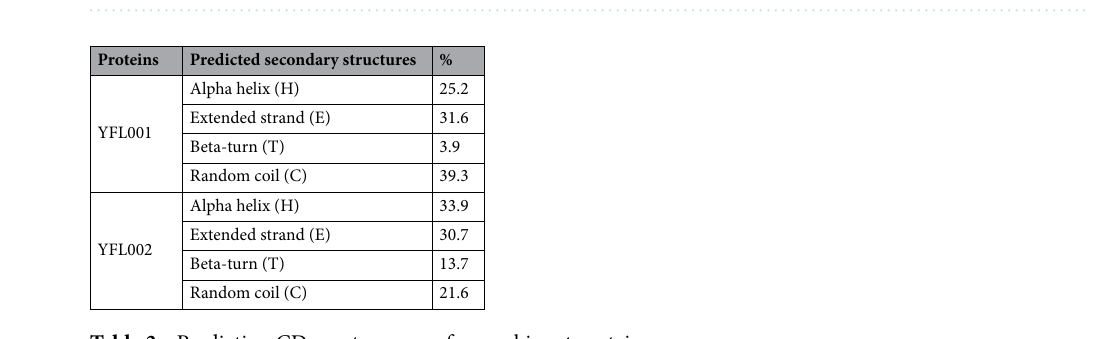
Figure 7. CD structural analysis of the recombinant proteins: (A) Far-UV spectra; ( B) Near-UV spectra (YFL001 in green and YFL002 in blue, respectively).